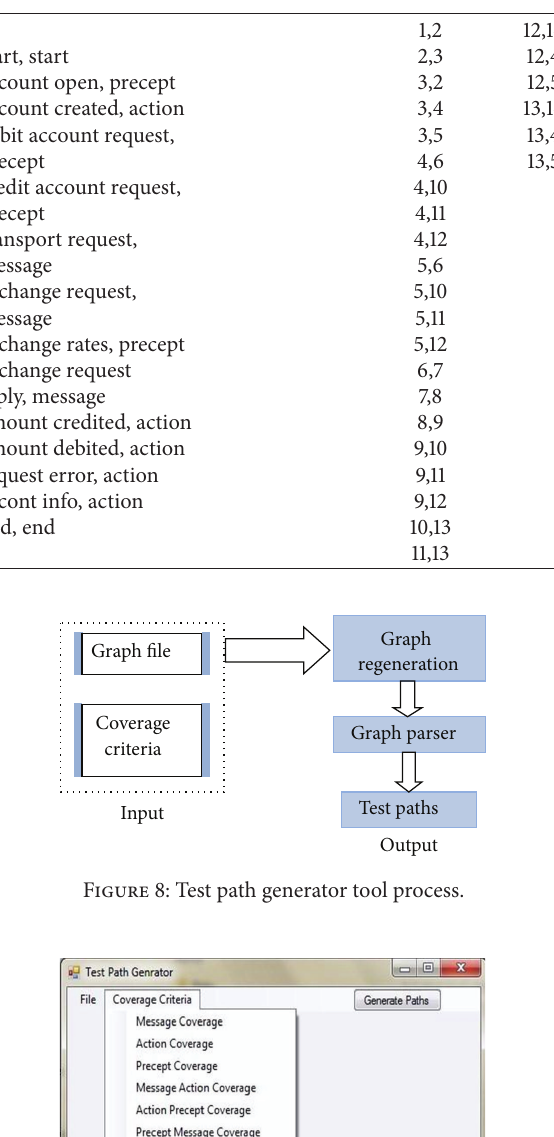
Table 2: Test path generator tool input file.